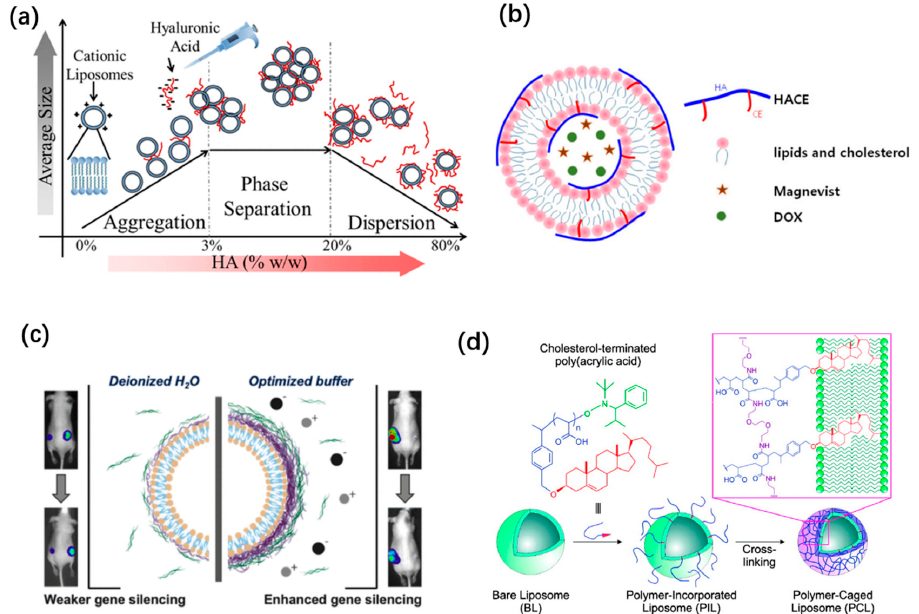
Figure 5. Schematic of liposomes coated with polymers. ( a ) Schematic of the configuration of low-molecular-weight HA/liposome complex. Reprinted with permission from Ref. [113]. Copyright © 2015, American Chemical Society. ( b ) Liposomes modified with hyaluronic acid–ceramide (HA–CE), whereas multiple hydrophobic anchors were introduced to HA. Reprinted with permission from Ref. [114]. Copyright © 2013 Elsevier B.V. All rights reserved. ( c ) Layer-by-layer (LbL) deposition of appositively charged polyelectrolytes. Enhanced therapeutic efficacy was obtained under optimized LbL deposition conditions. Reprinted with permission from Ref. [115]. Copyright © 2019, American Chemical Society. ( d ) Polymer-caged liposomes. Liposomes were modified with poly(acrylic acid)- cholesterol, followed by cross-linking with diamine. Reprinted with permission from Ref. [116]. Copyright © 2007, American Chemical